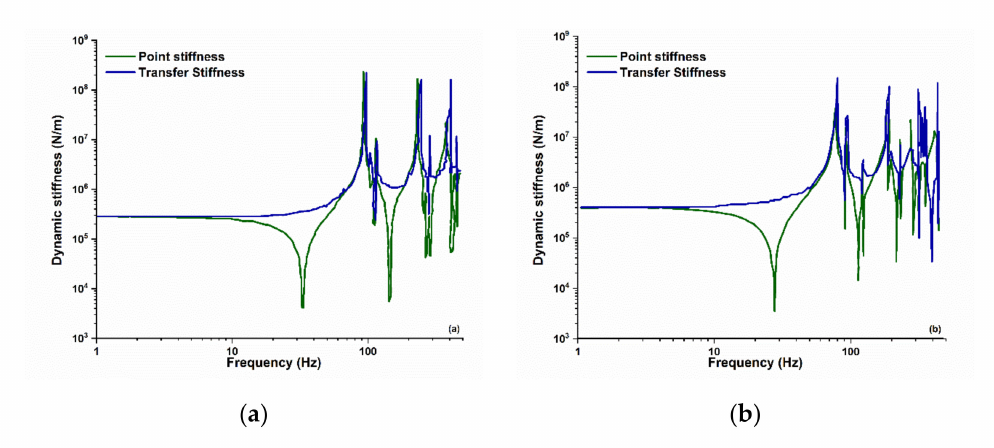
Figure 9. Dynamic stiffness of springs and spring set: ( a ) inner and ( b ) outer spring.